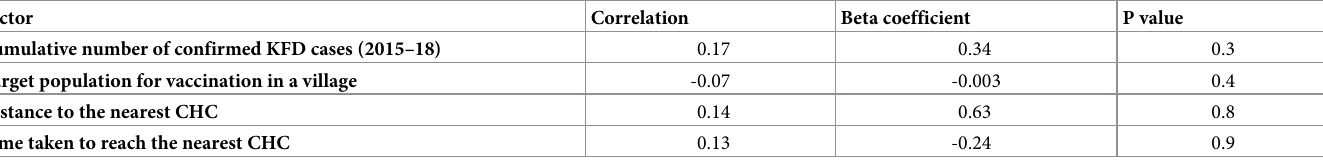
Table 2. Factors associated with KFD vaccination coverage for first dose using unadjusted linear regression analysis.